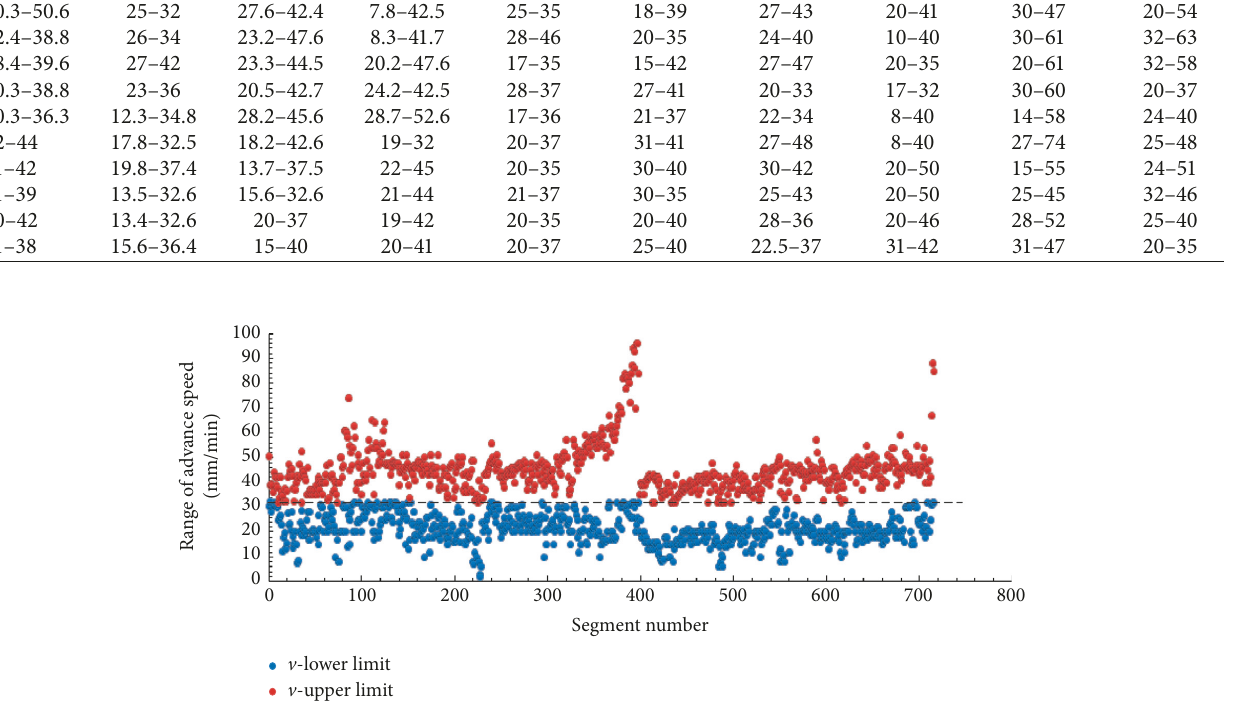
Figure 3: Distribution of the “normal excavation speed.” Table 4: Membership frequency of 23 mm/min belonging to the “normal excavation speed.”